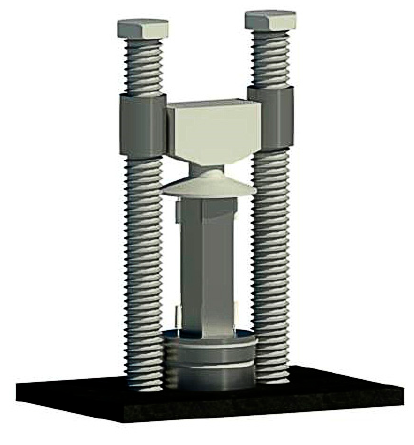
Figure 11. Loading device.